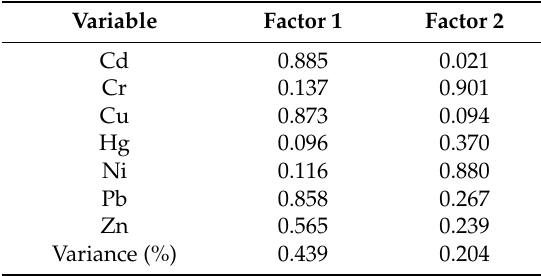
Table 6. Results of the factor